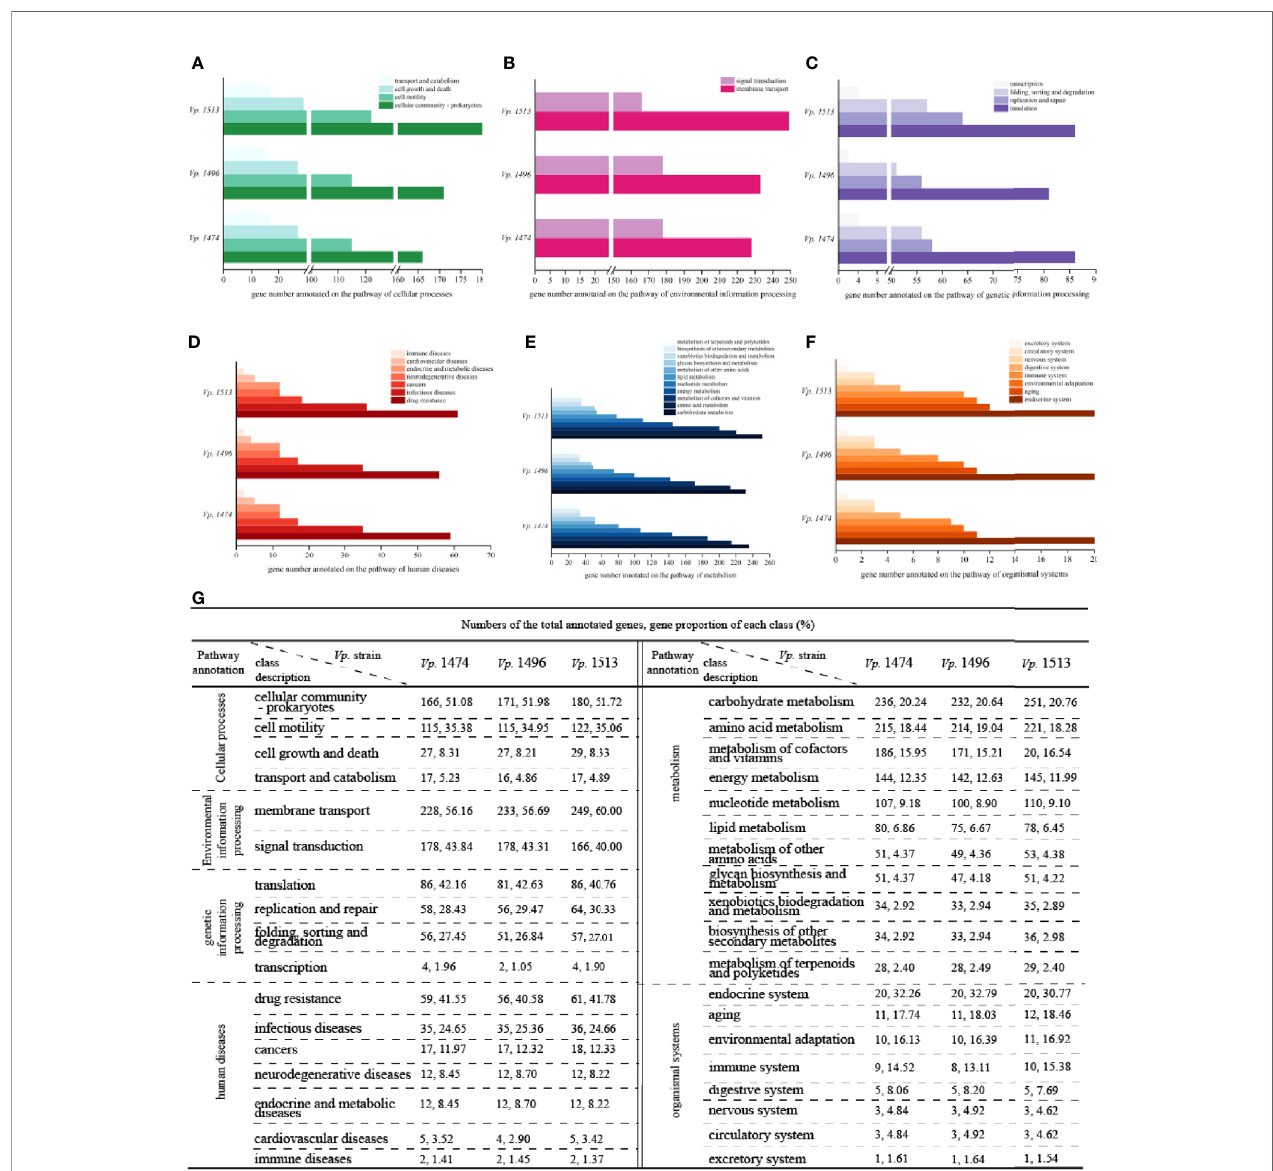
FIGURE 4 | KEGG pathway annotation of V. parahaemolyticus strains Vp . 1474, Vp . 1496, and Vp . 1513. (A) Statistical bar diagram of genes predicted to cellular processes pathway of the three strains. A total of 4 pathways were predicted within genome genes of the three strains. Gene numbers are shown on the horizontal axis. (B) Statistical bar diagram of genes predicted for environmental information processing pathways in the three strains. A total of 2 pathways were predicted within genome genes of the three strains. Gene numbers are shown on the horizontal axis. (C) Statistical bar diagram of genes predicted for genetic information processing pathway of the three strains. A total of 4 pathways were predicted within genome genes of the three strains. Gene numbers are shown on the horizontal axis. (D) Statistical bar diagram of genes predicted to human diseases pathways of the three strains. A total of 7 pathways were predicted within genome genes of the three strains. Gene numbers are shown on the horizontal axis. (E) Statistical bar diagram of genes predicted to metabolism pathways of the three strains. A total of 11 pathways were predicted within genome genes of the three strains. Gene numbers are shown on the horizontal axis. (F) Statistical bar diagram of genes predicted to organismal systems pathways of the three strains. A total of 8 pathways were predicted within genome genes of the three strains. Gene numbers are shown on the horizontal axis. (G) Statistical data of KEGG pathway annotation for the three